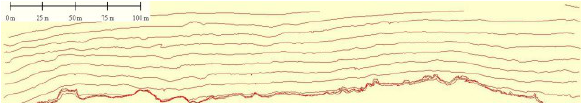
Figure 7. Contours generated from point cloud, Argilito area, Chavantes reservoir, August,